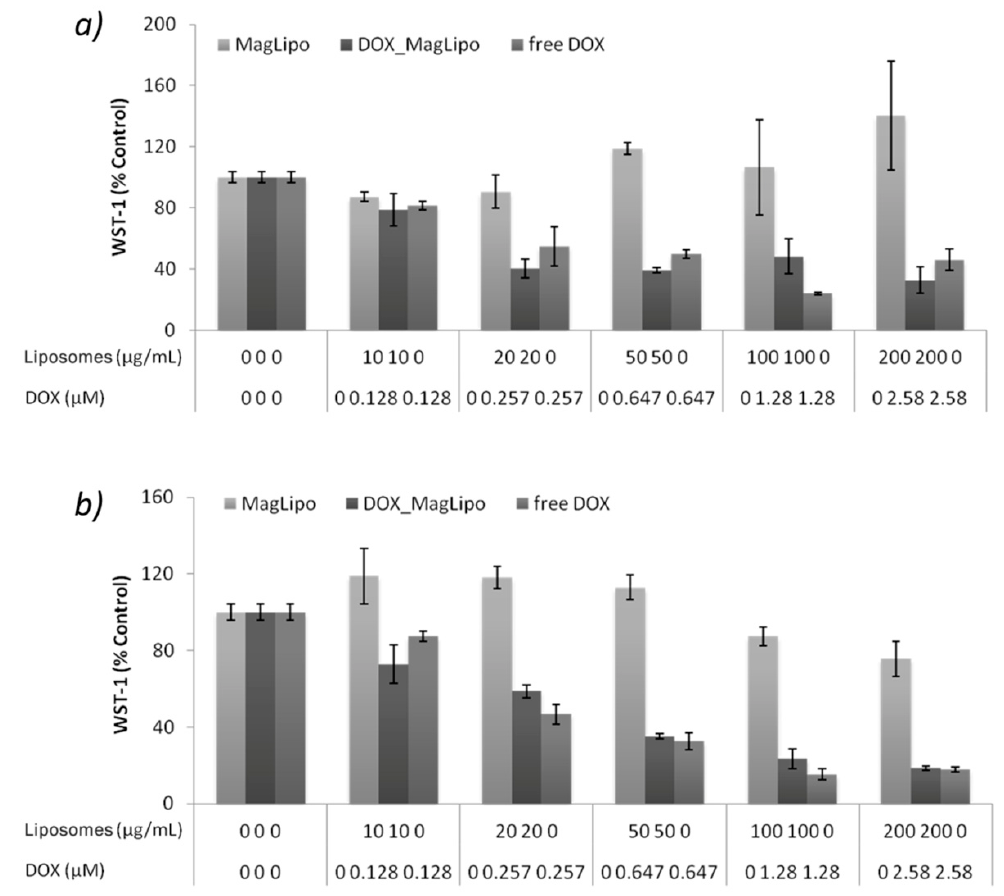
Figure 8. Metabolic WST-1 assay on HepG2 cancer cells after 24 h ( a ) and 72 h ( b ) of incubation with increasing concentrations of MagLipo, DOX_MagLipo, and free DOX.